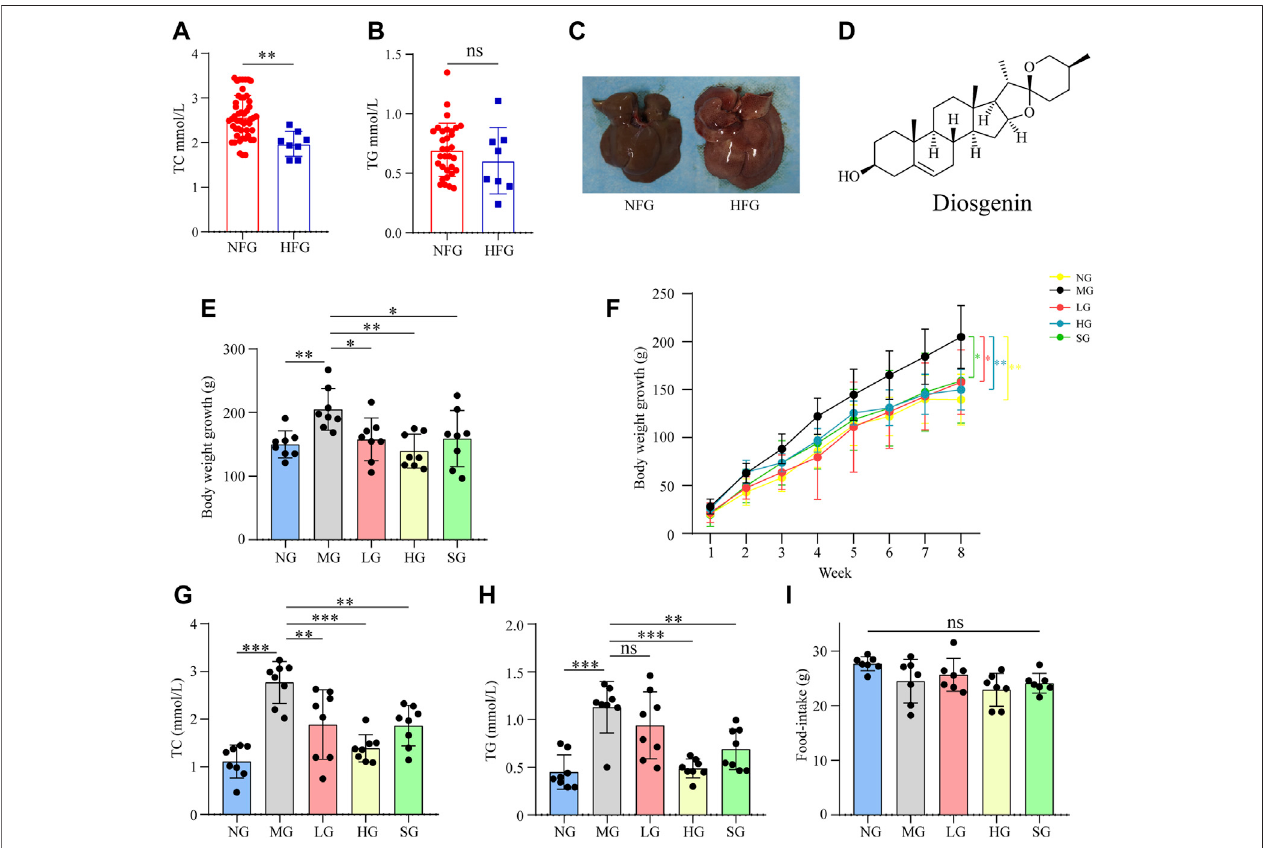
FIGURE 1 | Impacts of high fat diet and diosgenin on body weight, serum biochemical parameters, and food-intake in SD rats, *** p < 0.001, ** p < 0.01, * p < 0.05, ns: no signi fi cant difference (A) serum TC level in NFG (Normal feed for 4 weeks group) and HFG (high-fat diet-fed for 4 weeks group); (B) serum TG level in NFG and HFG; (C) macroscopic pictures of livers in NFG and HFG; (D) Chemical structure of diosgenin; (E) body weight growth over 8 weeks; (F) body weight growth curve in 8 weeks; (G) fi nal serum TC level; (H) fi nal serum TG level; (I) average food-intake in 8 weeks.